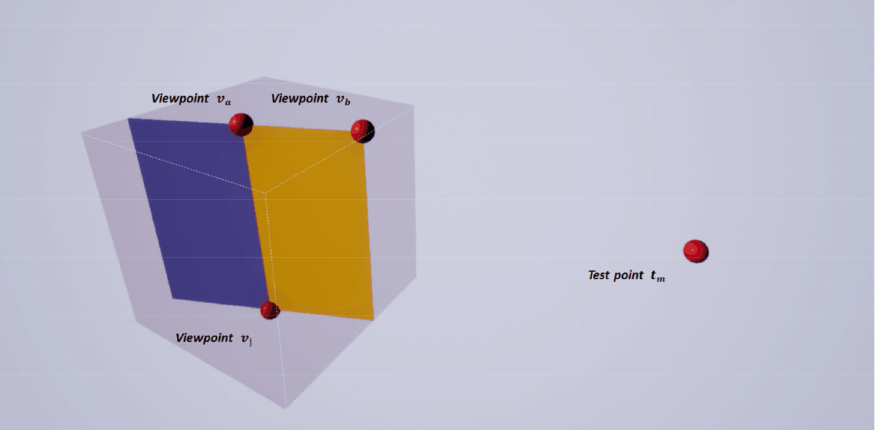
Figure 5. Diagram of the positional relationship between